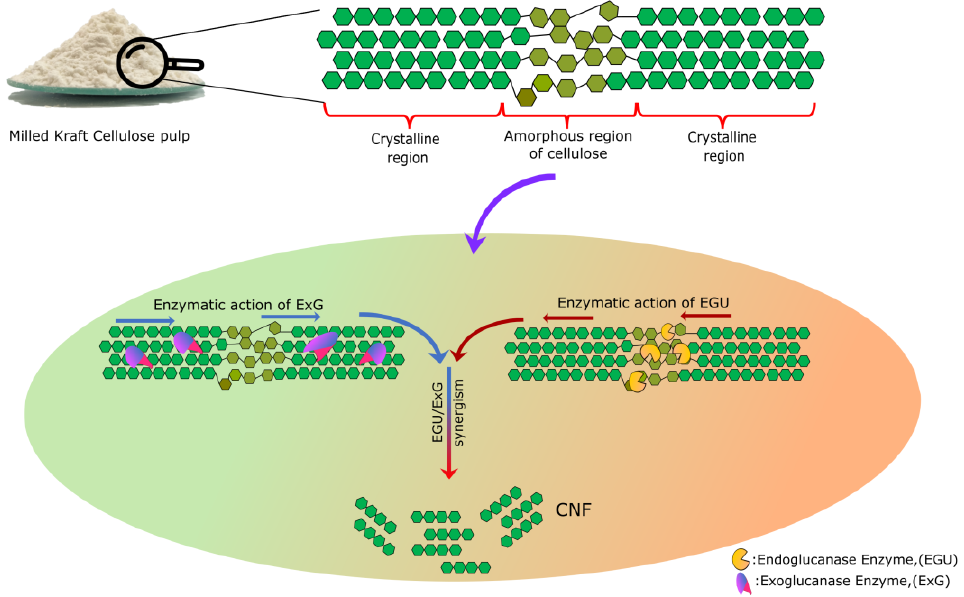
Figure 1. Schematic diagram of the production of CNF derived from the enzymatic hydrolysis of KCP by endo-exocellulase.